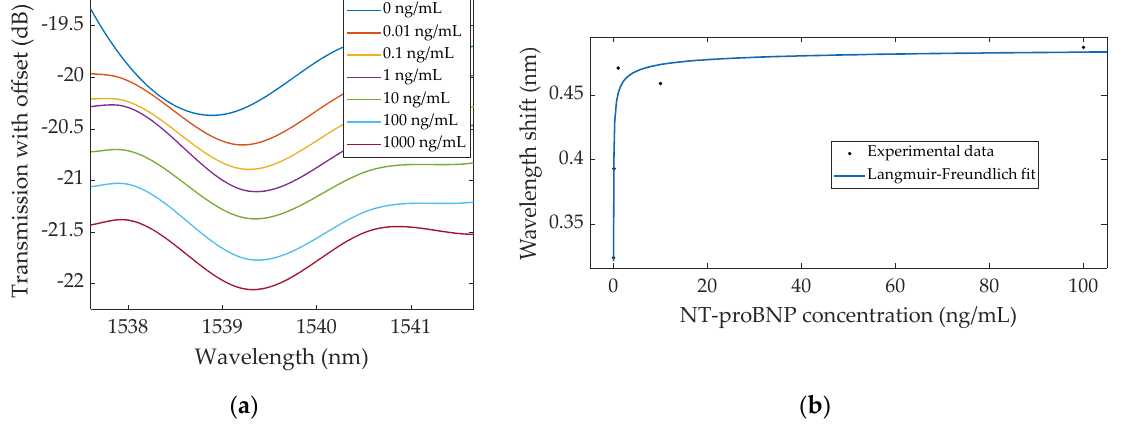
Figure 6. ( a ) Evolution of the lower envelope minimum from the biofunctionalized bare TFBG, recorded after each NT-proBNP concentration; ( b ) Respective wavelength shifts of the lower envelope, evidencing the Langmuir–Freundlich fit.